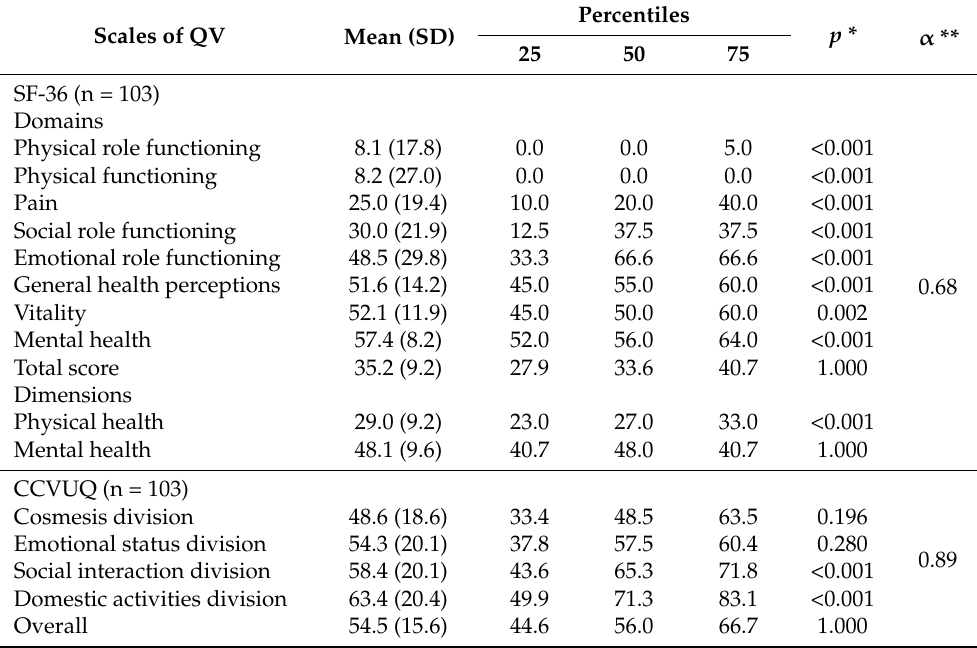
Table 2. Description of the participants’ scores and internal consistency of the QoL scales (SF-36 and CCVUQ).